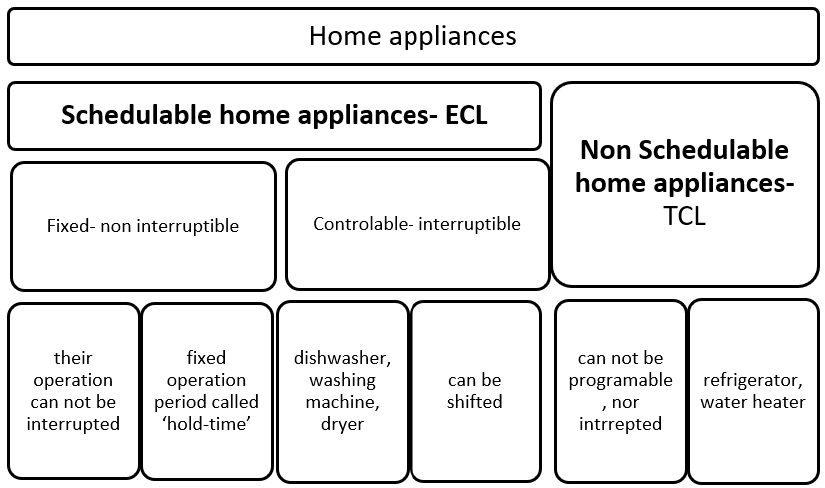
Figure 1. Classification of smart-home appliances.